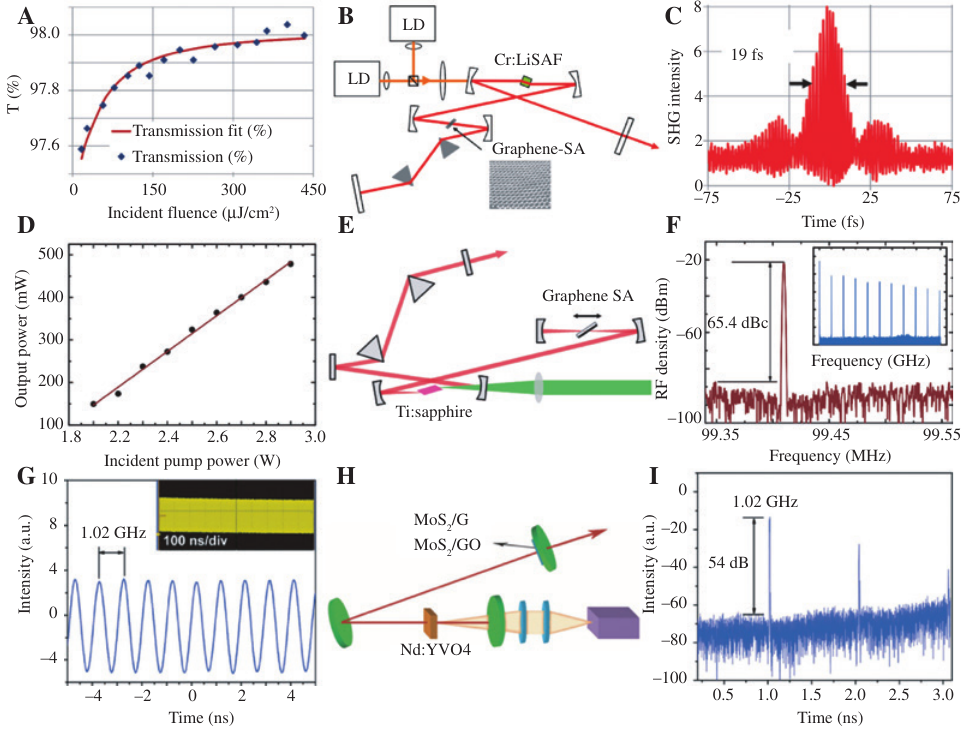
mode-locked near-infrared lasers. Figure 10: Performance of graphene and MoS 2 (A) Transmission vs. the incident fluence of the graphene SA. Reproduced with permission [145]. Copyright 2015, Optical Society of America. (B) Schematic and (C) autocorrelation trace of the graphene mode-locked Cr:LiSAF laser. Reproduced with permission [144]. Copyright 2017, Optical Society of America. (D) Average output power of the graphene mode-locked Ti:sapphire laser; (E) schematic and (F) radiofrequency spectrum. Reproduced with permission [162]. Copyright 2016, Wiley Publishing. (G) Pulse trains; (H) schematic and (I) radiofrequency spectrum of the MoS /GO mode-locked laser. Reproduced with permission [183]. Copyright 2012, IOP 2